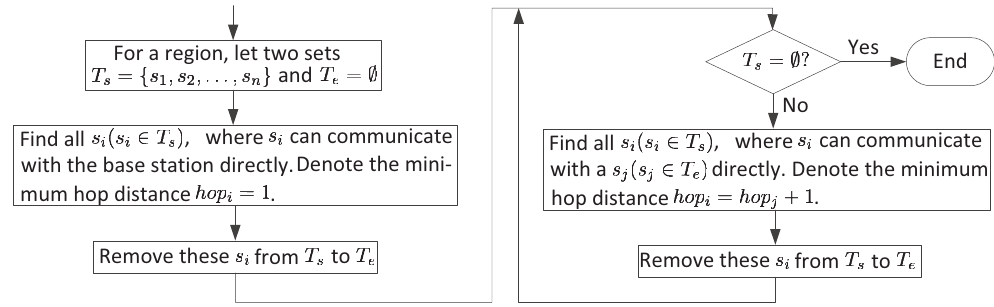
Figure 4. Identify the minimum hop distance for all